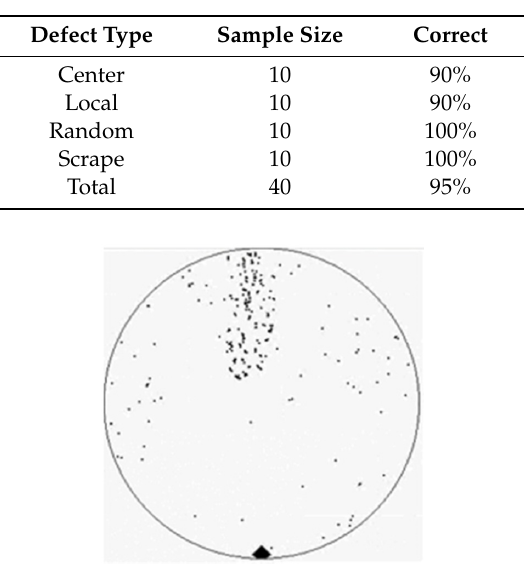
Figure 8. Wafer image exhibiting both scrape and local defect types.